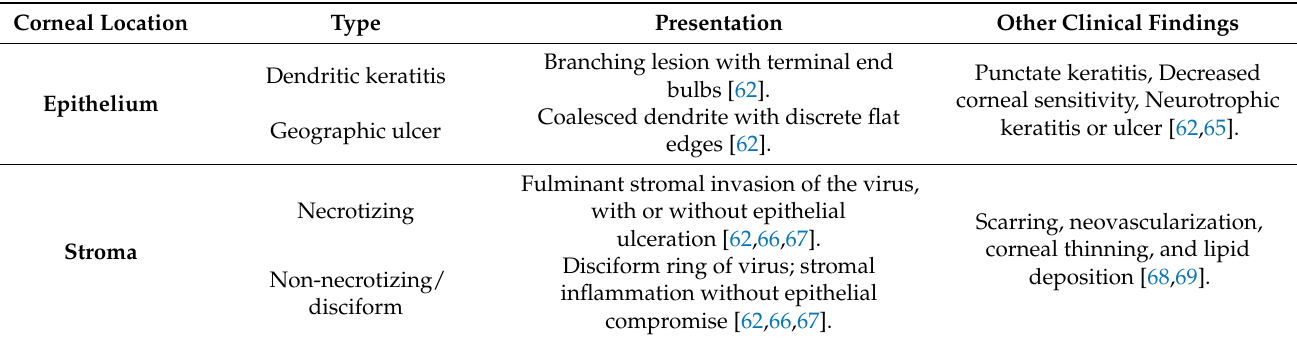
Table 1. Summary of corneal manifestations of